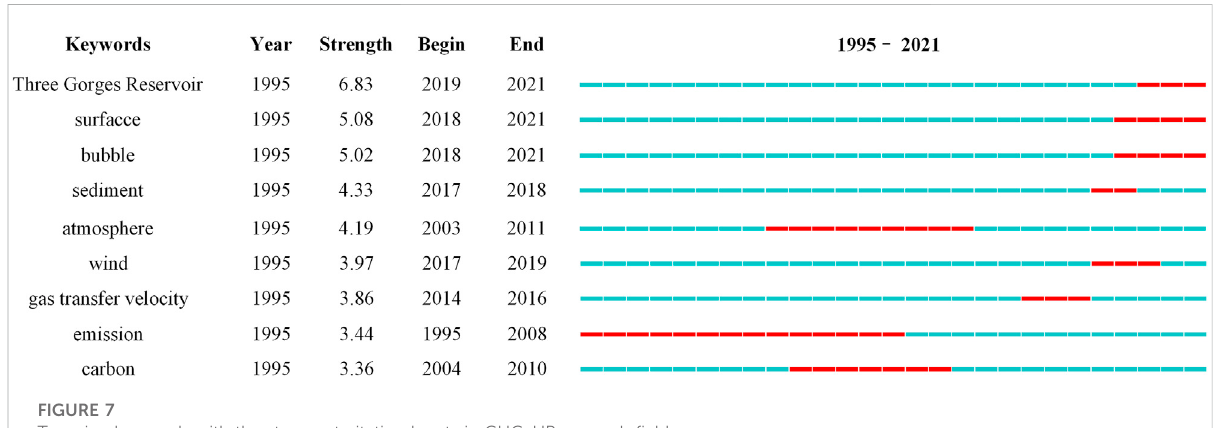
FIGURE 7 Top nine keywords with the strongest citation bursts in GHG-HR research fi